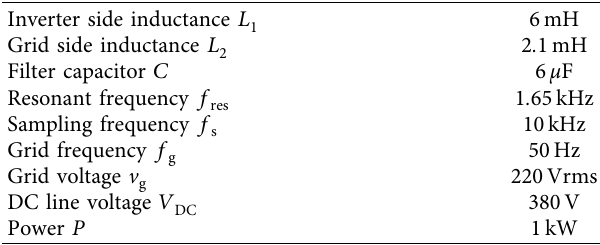
Table 2: LCL filter parameters and grid characteristics.